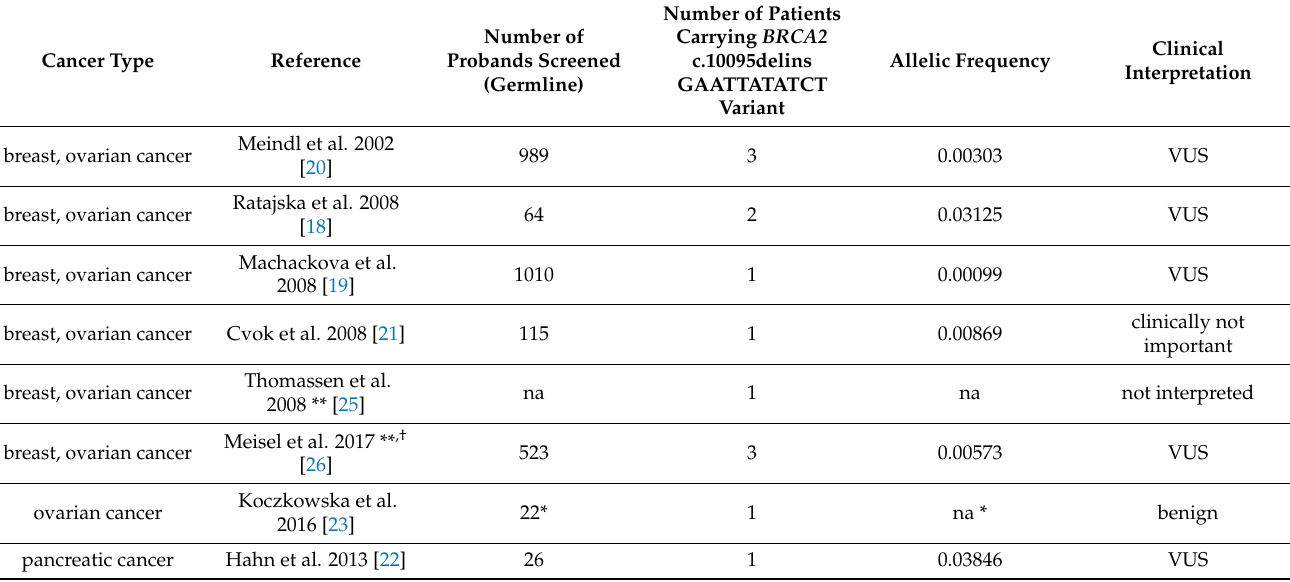
Table 3. Prevalence of BRCA2 c.10095delinsGAATTATATCT based on literature